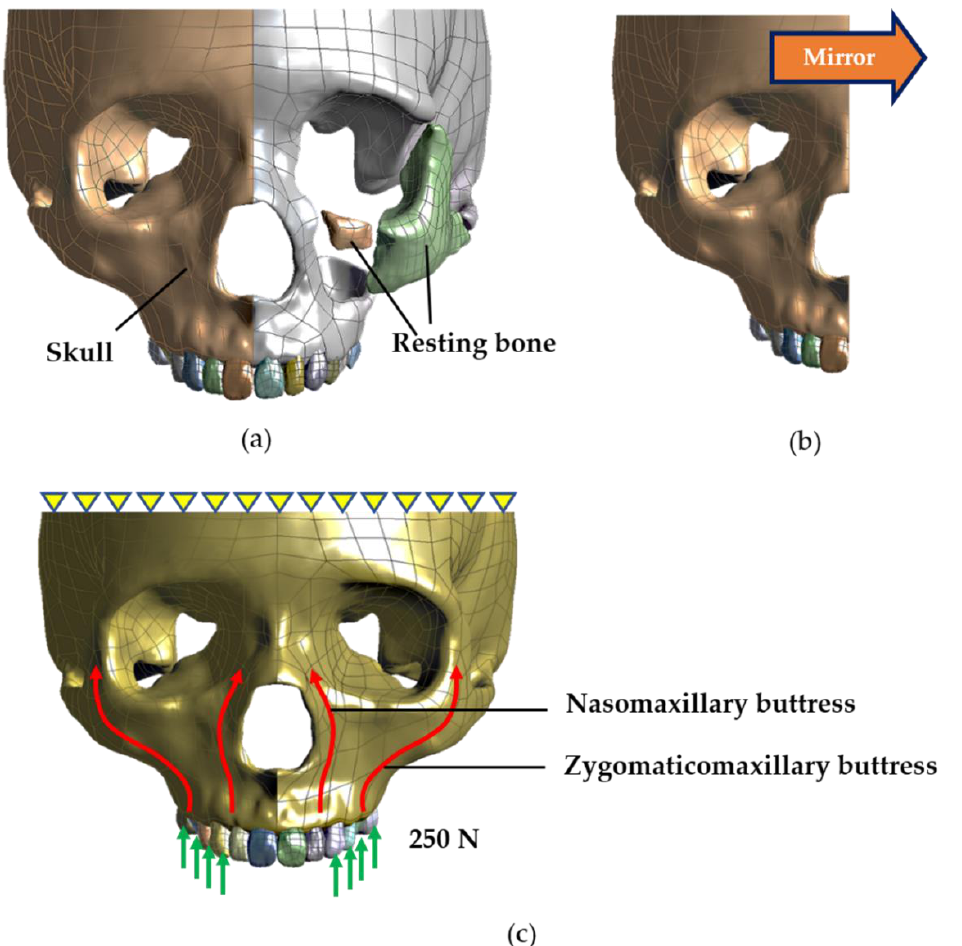
Figure 1. Three-dimensional (3D) reconstruction model of the ( a ) zygomaticomaxillary complex (ZMC) fracture; ( b ) the right intact part of the ZMC model; ( c ) a whole intact facial skeletal model (denoted as the IFS model).